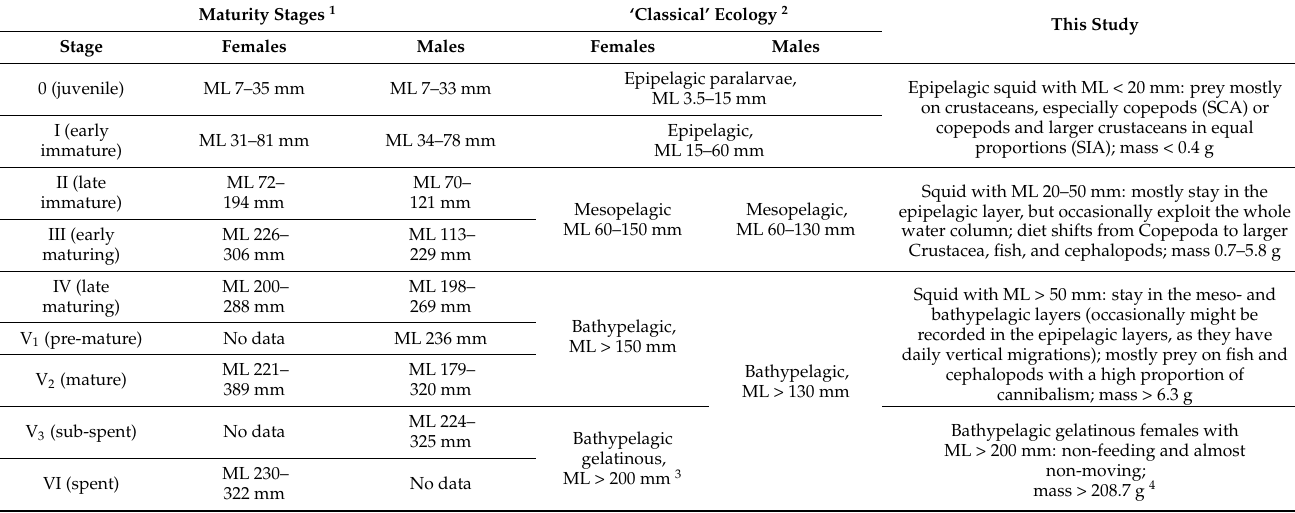
Table 7. Different approaches to define ontogenetic stages with different ecological roles in Gonatus fabricii . ML: mantle length, TL: trophic level, SCA: stomach content analysis, and SIA: stable isotope